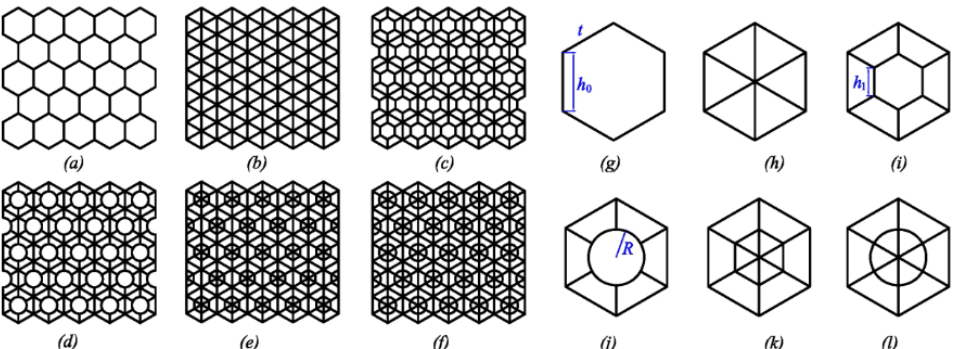
Figure 1. Honeycomb structures [1].